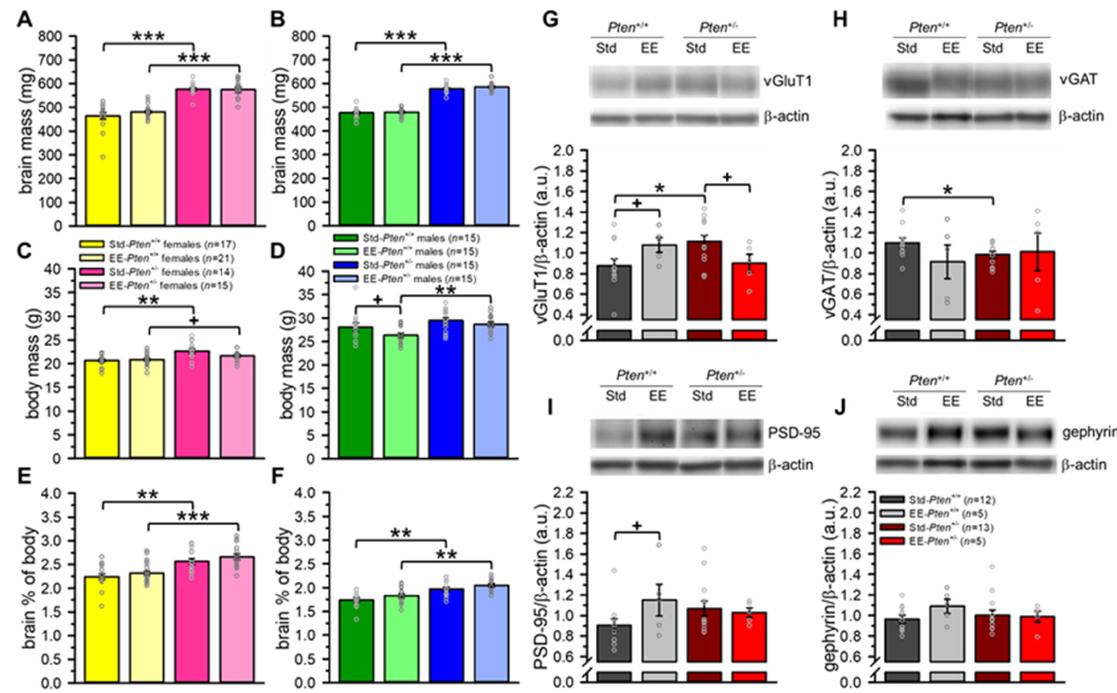
Figure 5. Environmental enrichment has no effect on brain overgrowth, but rescues altered E/I balance in Pten +/ − mice. (A–B ) Both Std- Pten +/ − and EE- Pten +/ − females ( A ) and males ( B ) had increased absolute brain mass relative to Pten +/+ mice in the same conditions. ( C , D ) Body mass in Std- Pten +/+ and EE- Pten +/+ females was lighter than Std- Pten +/ − and EE- Pten +/ − females, respectively ( C ), and EE- Pten +/+ male mice were lighter than both EE- Pten +/ − males and Std- Pten +/+ males ( D ). ( E–F ) Both Std- Pten +/ − and EE- Pten +/ − females ( E ) and males ( F ) show increased brain mass relative to body mass (brain mass/body mass × 100). ( G , H ) Synaptosomal levels of excitatory ( G ) and inhibitory ( H ) pre-synaptic proteins in the frontal cerebral cortex were altered by genotype and condition. Excitatory pre-synaptic protein vGluT1 was elevated in Std- Pten +/ − mice relative to Std- Pten +/+ mice ( G ). EE rescued this phenotype by decreasing vGluT1 levels in EE- Pten +/ − mice, but also elevated vGluT1 in EE- Pten +/+ mice ( G ). Inhibitory pre-synaptic protein vGAT was reduced in Std- Pten +/ − mice compared to Std- Pten +/+ mice, and this phenotype was suppressed by EE ( H ). ( I , J ) Synaptosomal levels of excitatory ( I ) and inhibitory ( J ) post-synaptic proteins in the frontal cerebral cortex were largely unaffected by genotype or condition. Excitatory post-synaptic protein PSD-95 trended to increasing in EE- Pten +/+ mice relative to Std- Pten +/+ mice ( I ), but no other group differences were found for PSD-95 ( I ) or inhibitory post-synaptic protein gephyrin ( J ). Mean ± SEM. *** p < 0.001, ** p <0.01, * p < 0.05, + p < 0.10. Std, standard housing; EE, environmental enrichment.